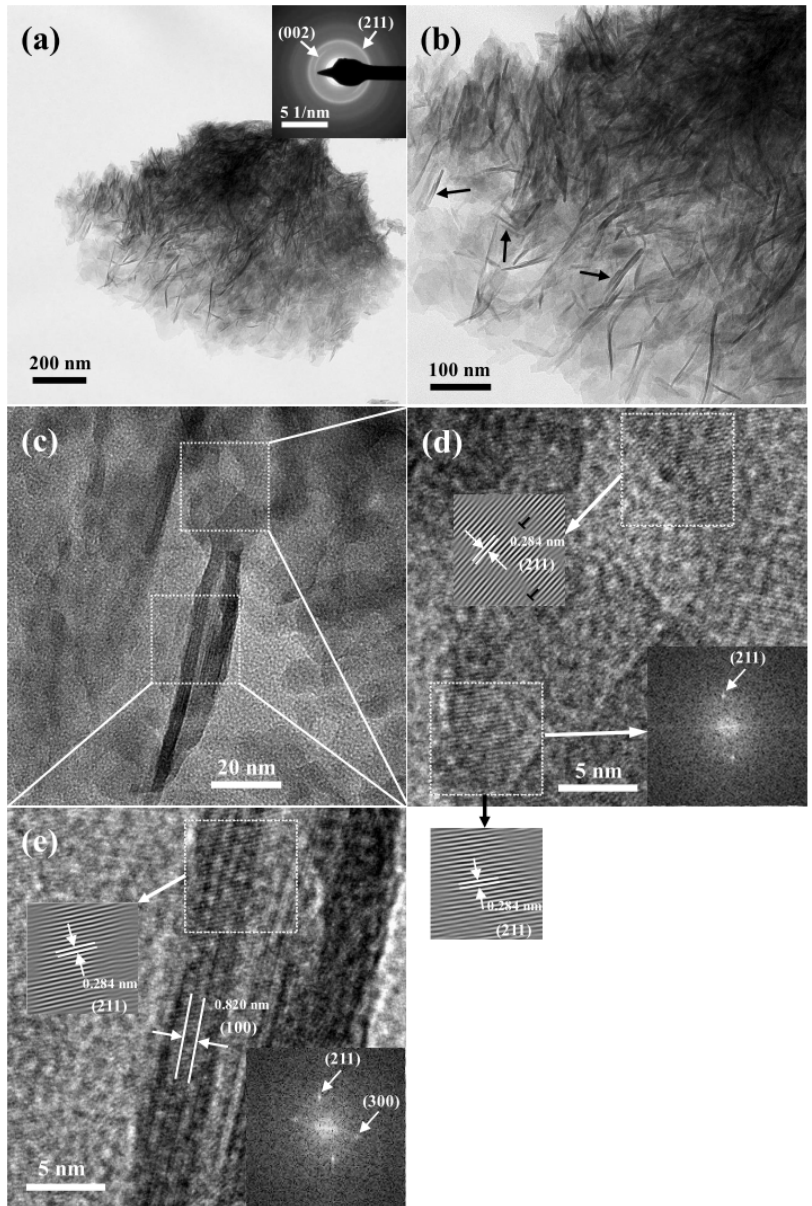
Figure 12. TEM images of precipitated apatite on the surface of the β‐ Ta coating after soaking in Hank’s solution for seven days: ( a ) low magnification TEM image showing numerous needle ‐ like apatite crystals, and SAED pattern shows characteristic (002) planar arcs, related to preferential orientation of the apatite crystals; ( b ) higher magnification TEM image taken from image ( a ) shows some locally parallel apatite needles (marked with arrows); and ( c ) a close ‐ up view of two parallel apatite needles. HRTEM images of: ( d ) flake ‐ like; and ( e ) needle ‐ like apatite crystals in image ( c ). The insets in ( d ) and ( e ) are corresponding fast Fourier transform (FFT) patterns.